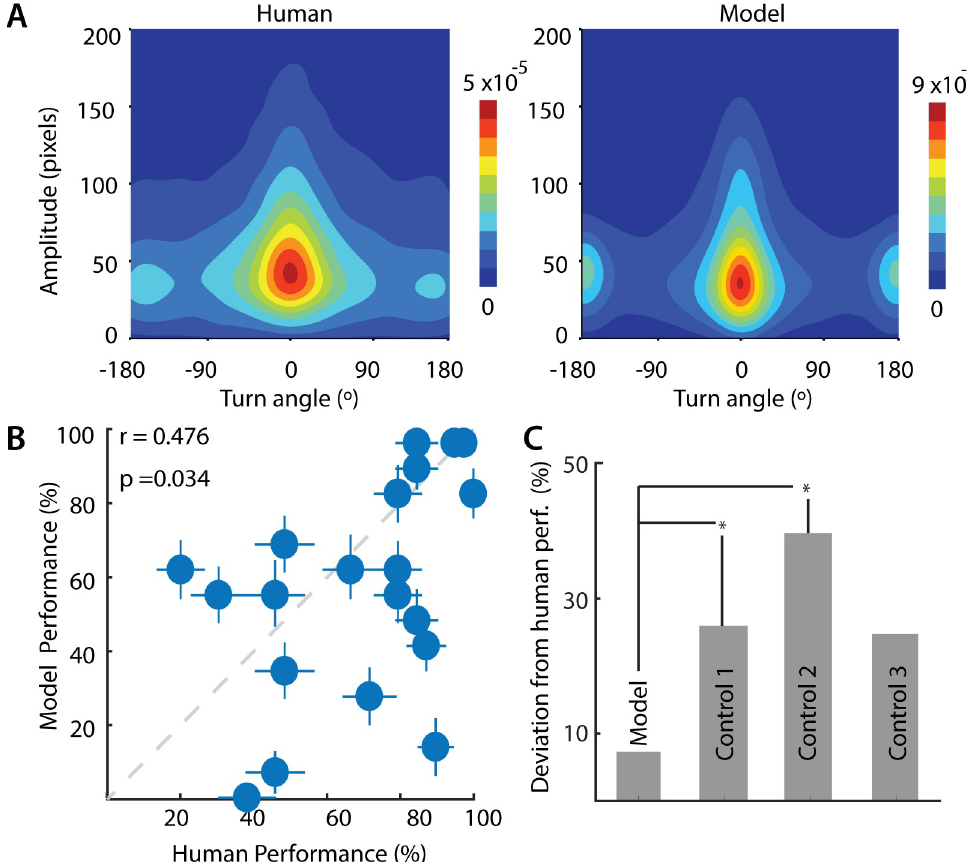
Fig 6. Comparison between human and model performance. A. (Left) Joint distribution of saccade amplitude and saccade turn angle for human participants (averaged over n = 39 participants). Colorbar: Hotter colors denote higher proportions. (Right) Same as in the left panel, but for model, averaged over n = 40 simulations. B. Correlation between change detection success rates for human participants (x-axis) and the model (y-axis). Each point denotes average success rates for each of the 20 images tested, across n = 39 participants (human) or n = 40 iterations (model). Error bars denote standard error of the mean across participants (x-axis) or simulations (y-axis). Dashed gray line: line of equality. C. Average absolute deviation from human performance of the sequential probability ratio test (SPRT) model (Model, leftmost bar), for a control model in which evidence decayed rapidly (Control 1, γ = 1; second bar from left), for a control model in which the stopping rule was based on the derivative of the posterior odds ratio (Control 2; third bar from left), or for a control model which employed a random search strategy (Control 3, T = 10 4 ; rightmost bar). p-values denote significance levels following a paired signed rank test, across n = 20 images ( � p < 0.05).